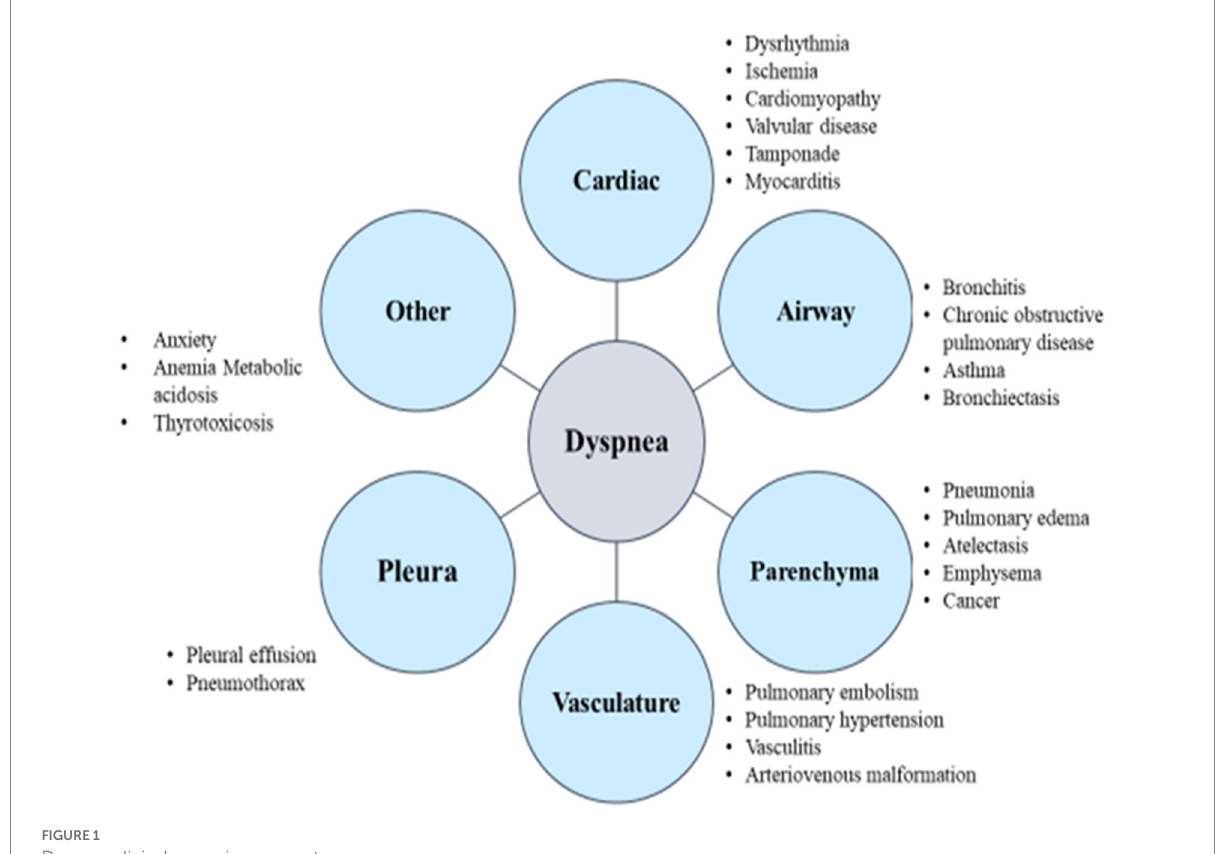
FIGURE 1 Dyspnea clinical reasoning concept map.